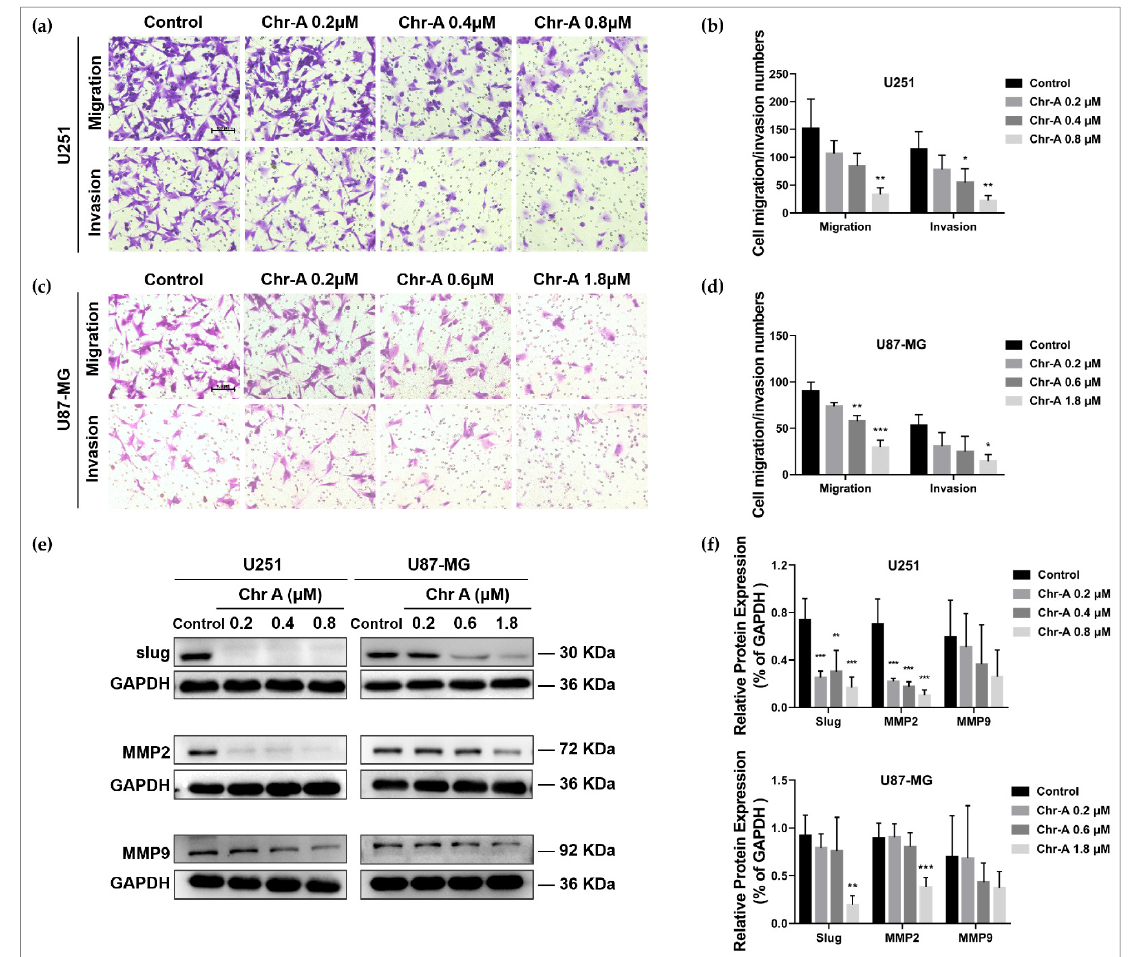
Figure 3. Chr-A suppresses migration and invasion of the U251 and U87-MG cells. ( a , b ) The Transwell assay shows that Chr-A restrained metastasis and invasiveness of the U251 cells ( n = 3). Scale bar = 100 μ m. ( c , d ) The Transwell assay shows that Chr-A restrained metastasis and invasiveness of U87-MG cells ( n = 3). Scale bar = 100 μ m. ( e , f ) The Western blot results show that Chr-A downregulates the expression of slug, MMP2 and MMP9 ( n = 4). Data are demonstrated as mean ± SD, * p < 0.05, ** p < 0.01 and *** p < 0.001 vs. the control group.